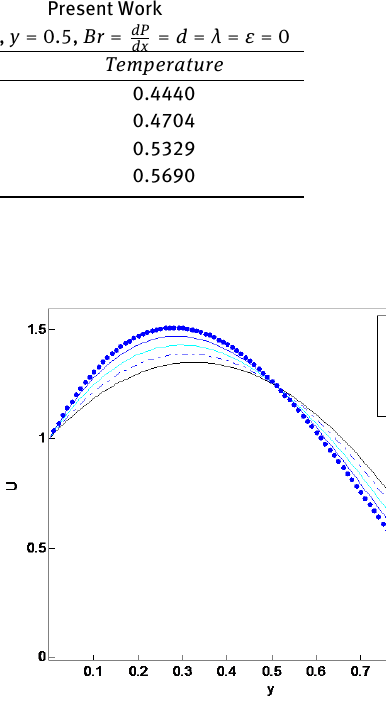
Figure 6: Velocity profile for different values of mixed convection parameter Gre ( Br = 0.2 , S = 0.4 , λ = −0.3 , ε = −0.3 , d = 0.2 , q = 1